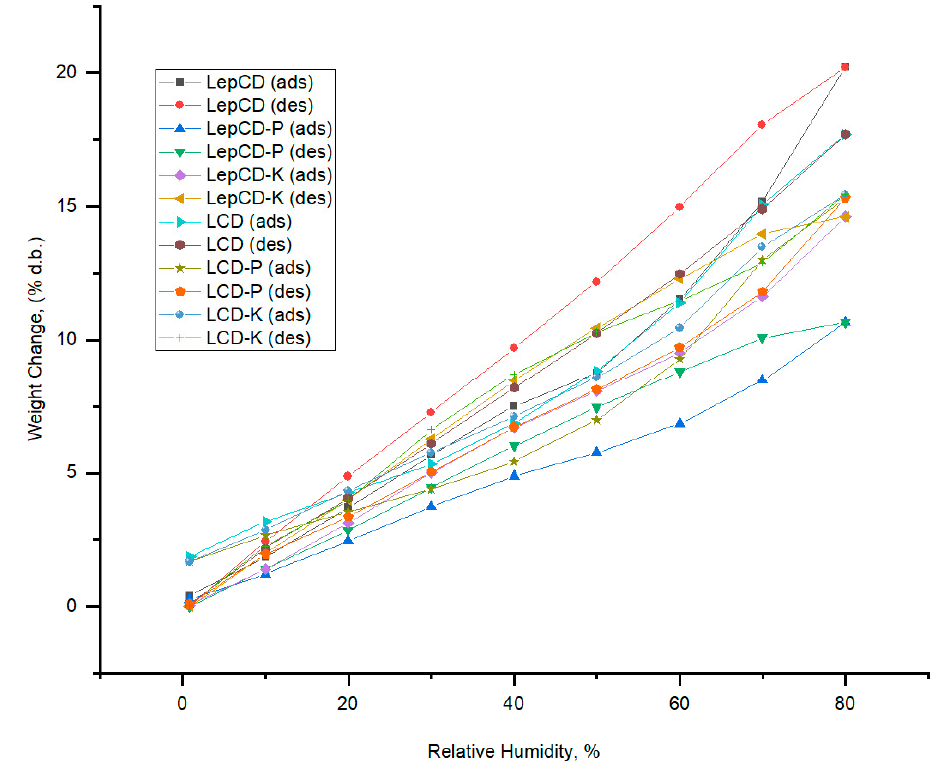
Figure 3. Water uptake properties of the studied materials (ads–adsorption; des–desorption).